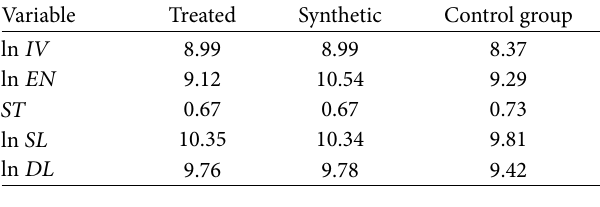
Table 1: Summary statistics.